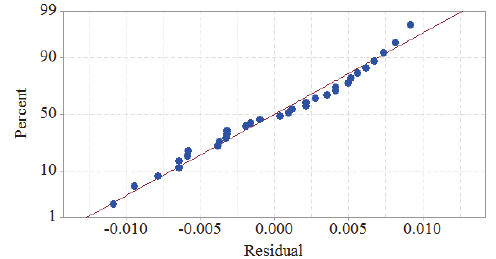
Fig.3. Normal probability plot of surface roughness of EN31 soft steel